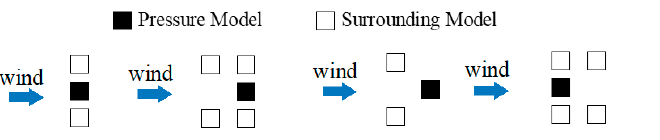
Figure 1. The same blocking ratio with a different layout of the surrounding buildings.